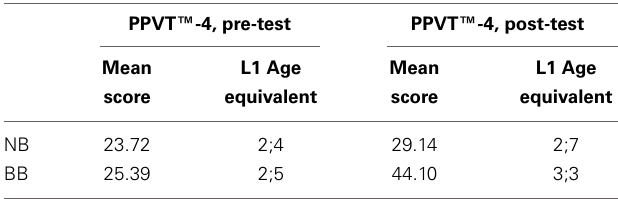
BB, bilingually-based; NB, native